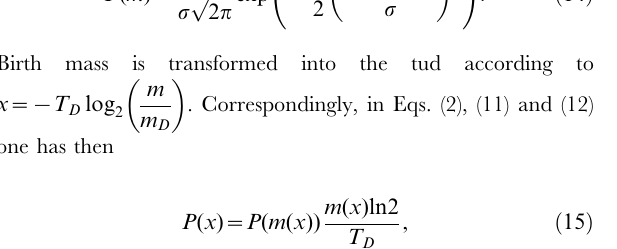
Figure S6 Effect of noisy switching on phenotypic = T div is shown diversification described by model 2. T eff 2 as function of average switching time T S and adaptation time T A . The diversification probability is p ~ 0 : 01 . In figures A and B, the population growth was followed for 8 switching periods. In A, switching times are drawn from a normal distribution, in B from an exponential distribution. Figures C and D show averages over 100 runs shown in A and B, respectively. Birth mass noise is